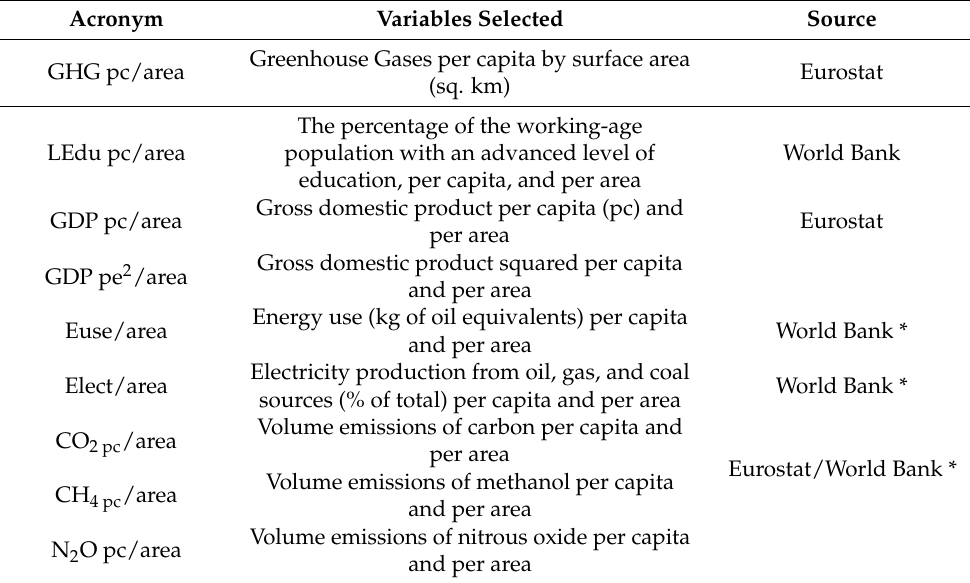
Table 1. Variables